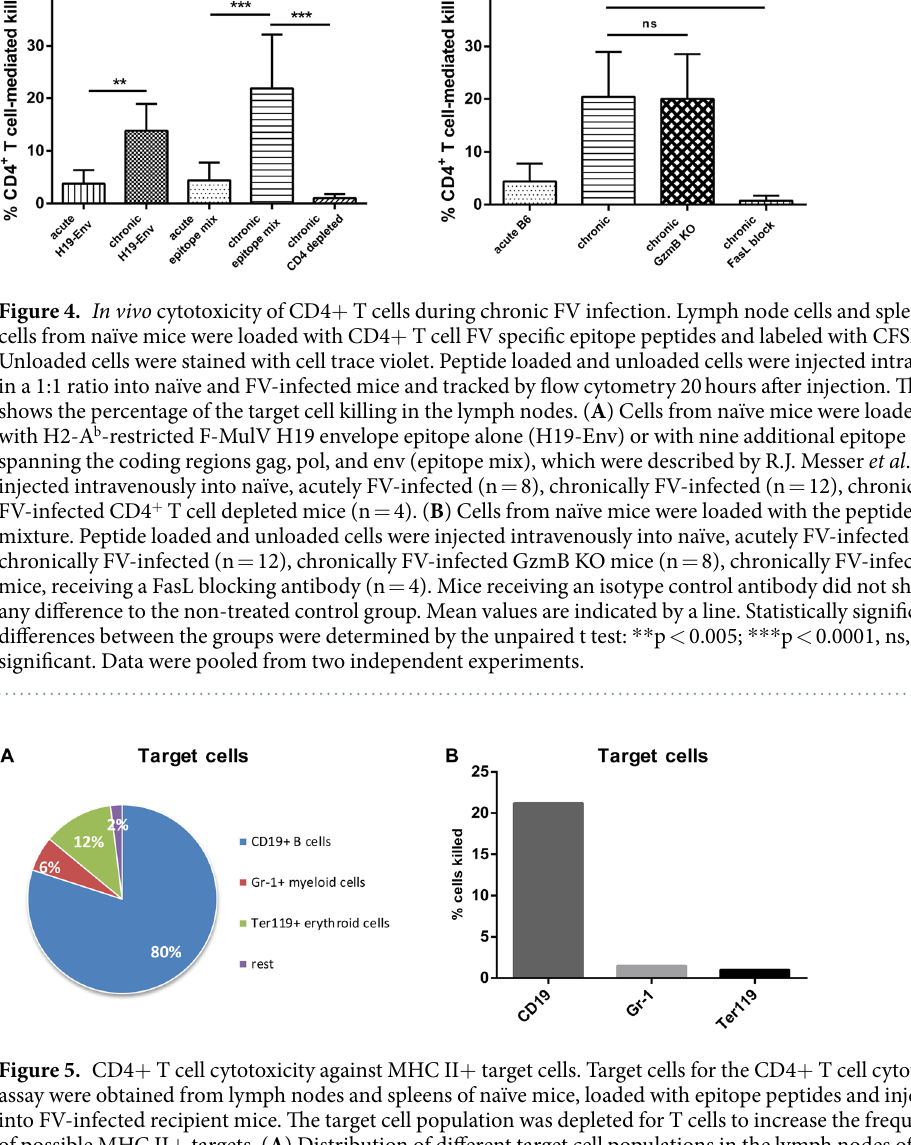
pathway. Killing in granzyme B knockout mice was equivalent to that observed in wild type mice (Fig. 4B) con- firming that the cytotoxicity by CD4 + T cells was not dependent on the exocytosis pathway. In contrast, CD4 + T cell-mediated killing was completely abrogated in chronically infected mice following injection of FasL-blocking antibody (Fig. 4B). These results indicated that the CD4 + T cell cytotoxicity during chronic FV infection was mediated by the Fas/FasL pathway. Next, we wanted to determine the target cell populations that were killed by the FasL-expressing CD4 + T cells. First, the distribution of target cells in lymph nodes from uninfected recipient mice was analyzed. Figure 5A shows that CD19 + B cells form the major target cell population after transfer, but also Ter119 + erythroid cells and Gr-1 + myeloid cells were detectable. Since T cells were depleted prior to injection of the target cells in order to enrich MHC class II-positive cells, virtually no CD3 + T cells were found. Then, the percentage of target cell killing in chronically FV-infected mice was determined for the different subpopulations. Only few Ter119 + erythroid precursor cells or Gr-1 + myeloid cells (less than 2%) were killed, whereas around 20% of the CD19 + B cells labeled with FV epitope peptides were eliminated in vivo (Fig. 5B). Thus, B cell killing accounted for nearly all the cytotoxic activity of CD4 + T cells that we detected in chronically FV-infected mice. This is in line